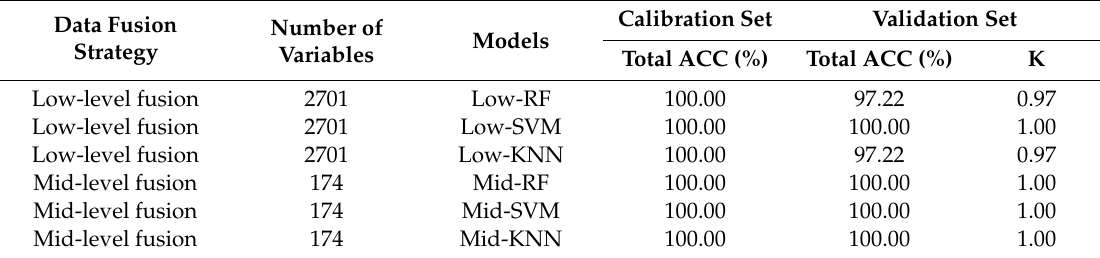
Table 10. The major parameters (accuracy and kappa) of the data fusion